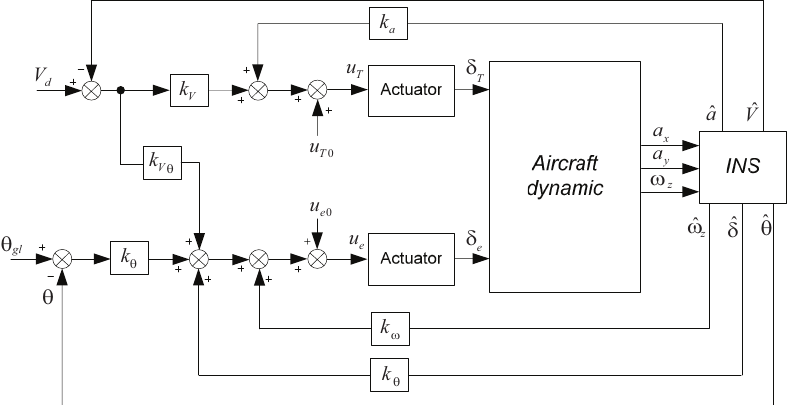
Figure 10. Glide-slope